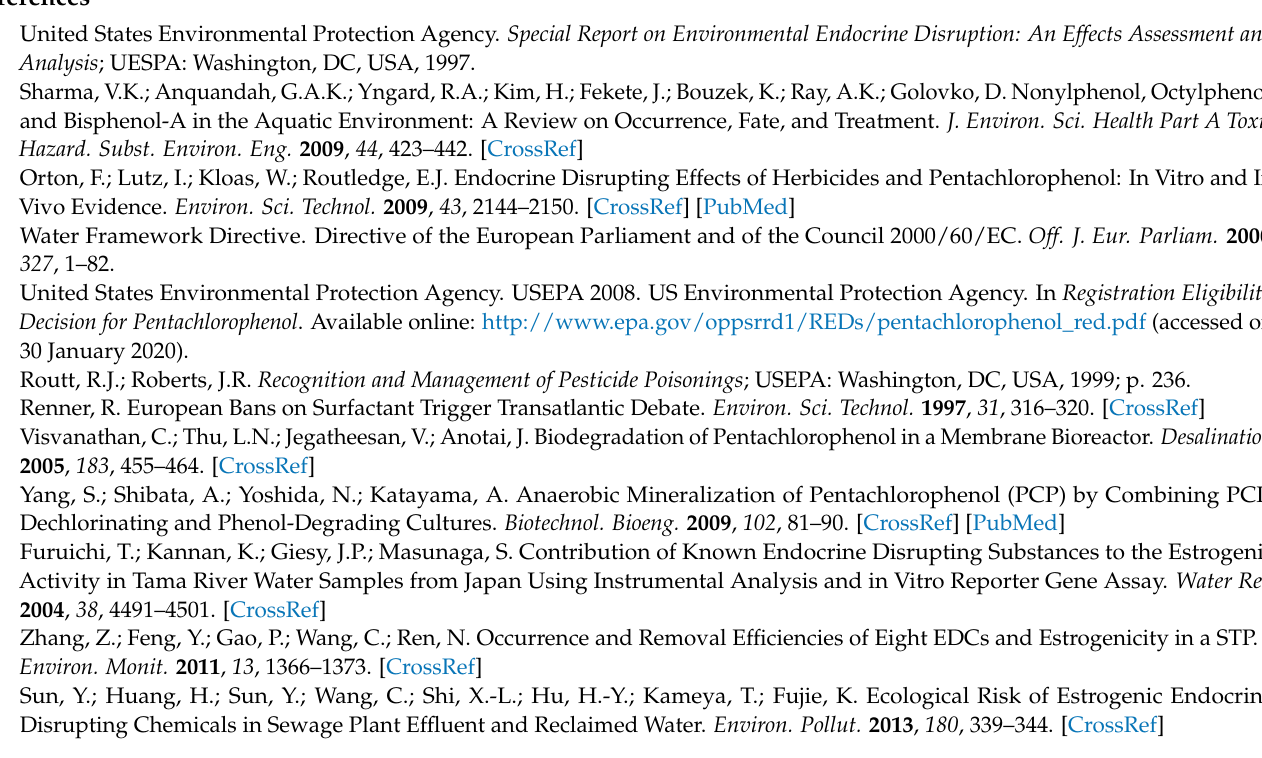
Table S1: Concentration of ammonia (NH 4+ ), nitrite (NO 2 − ), nitrate (NO 3 − ) and phosphate (PO 43 − ) ions in influent and effluent of CWs (mean and standard deviation, n = 3), irrigated along eight weeks with Ribeira de Joane water not doped (control) or doped with NP and OP, Table S2: Concentration of ammonia (NH 4+ ), nitrite (NO 2 − ), nitrate (NO 3 − ) and phosphate (PO 43 − ) ions in influent and effluent of CWs (mean and standard deviation, n = 3), irrigated along eight weeks with Ribeira de Joane water not doped (control) or doped with PCP. Table S3: Summary statistics of 16S rRNA gene amplicon sequencing for experiment#1, Table S4: Summary statistics of 16S rRNA gene amplicon sequencing for